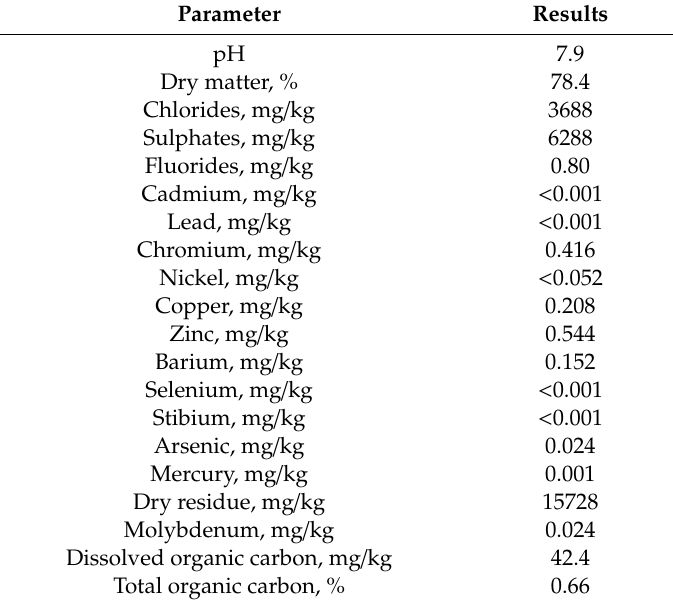
Table 3. Analysis of extractable metals in the solid residue and other properties of tannery